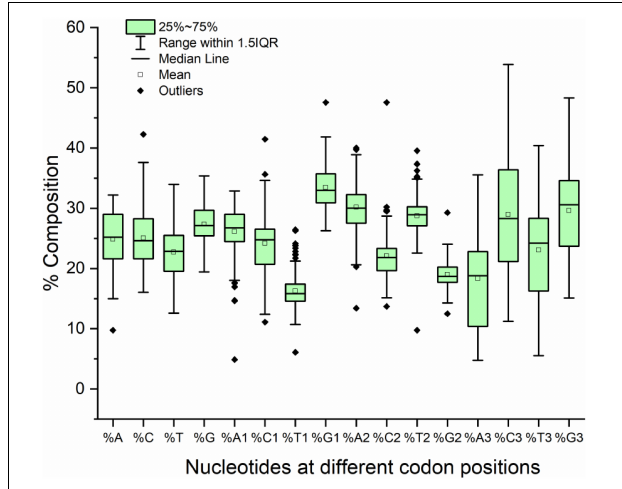
FIGURE 1 | Box plot with outliers presenting nucleotide composition in neurodegeneration-related